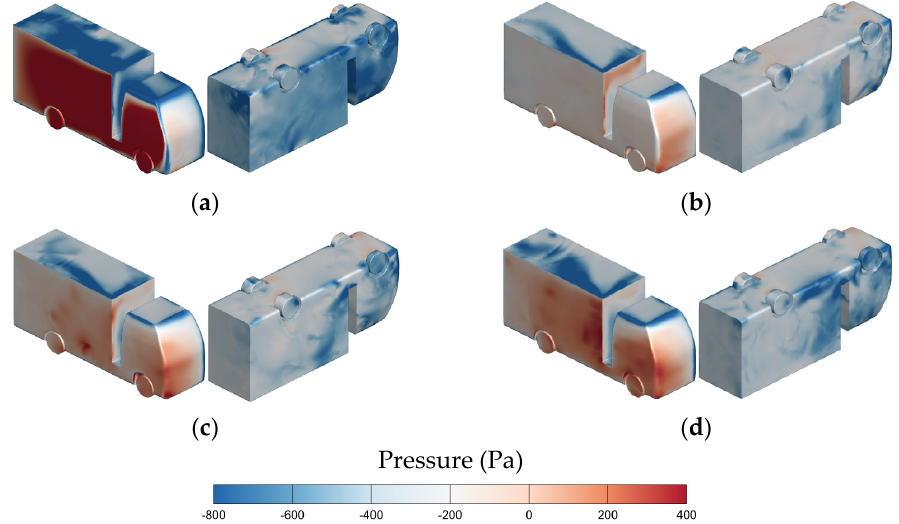
Figure 9. Pressure distribution for different porosity schemes (( a ) Bare bridge; ( b ) Scheme 1; ( c ) Scheme 2-1; ( d ) Scheme 3).